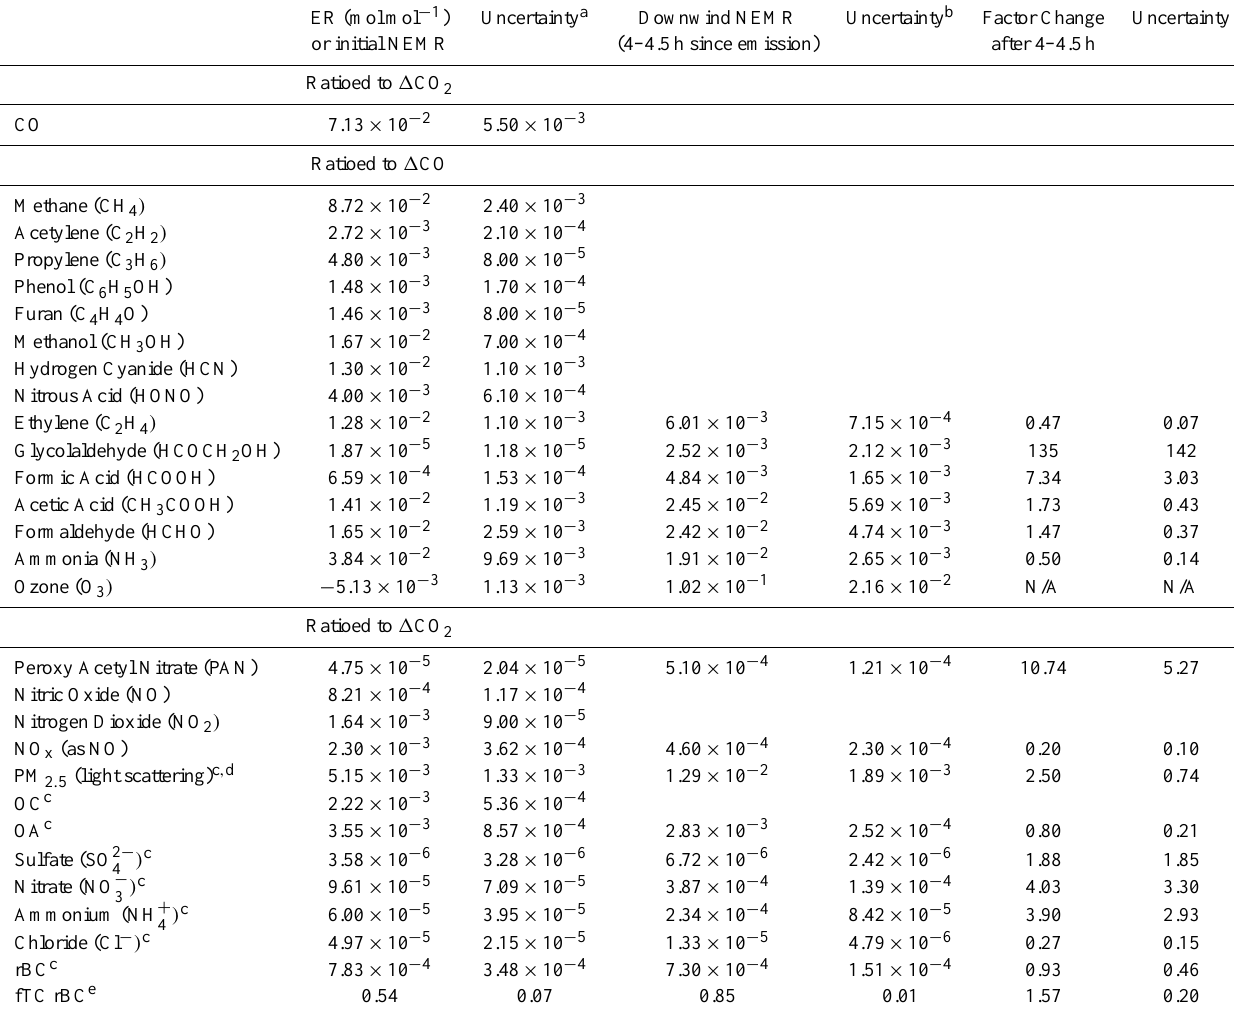
Table 2. Emission ratios (ER), initial and downwind NEMR for the Williams